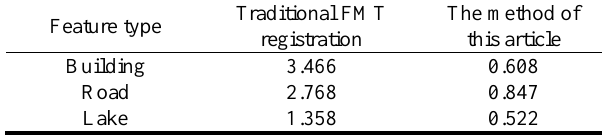
Table 1.Comparison of RMSE values after registration